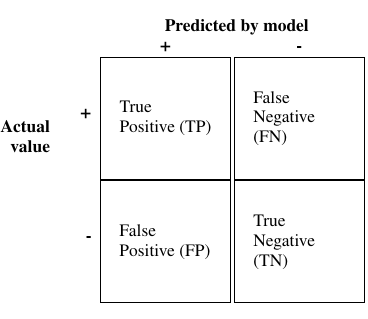
Table 2. Confusion